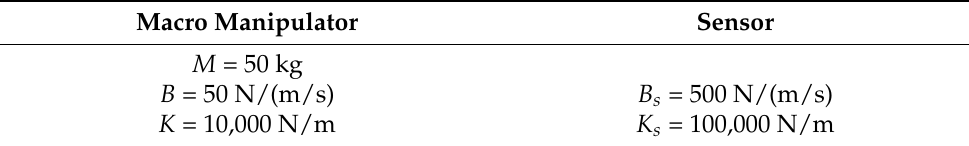
Table 2. The parameters of macro manipulator and force